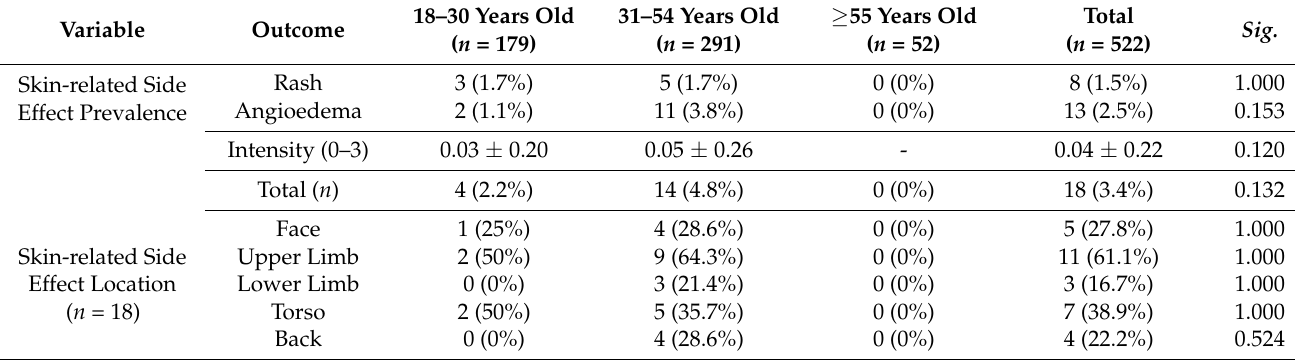
Table 9. Skin-related side effects of Slovak healthcare workers who received BNT162b2 and stratified by age group, February–March 2021 ( n =